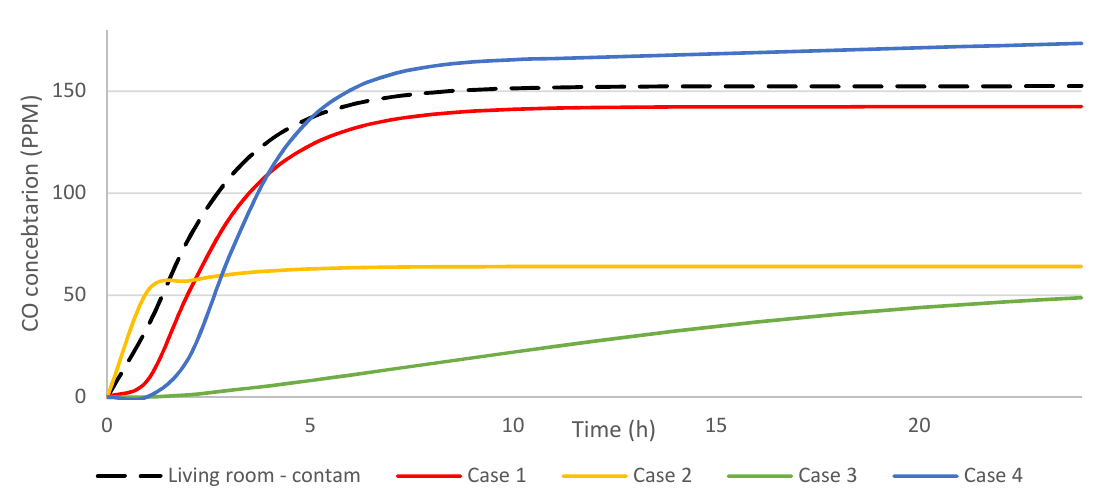
Figure 8. Coupled CONTAM and CFD0 results for the garage.